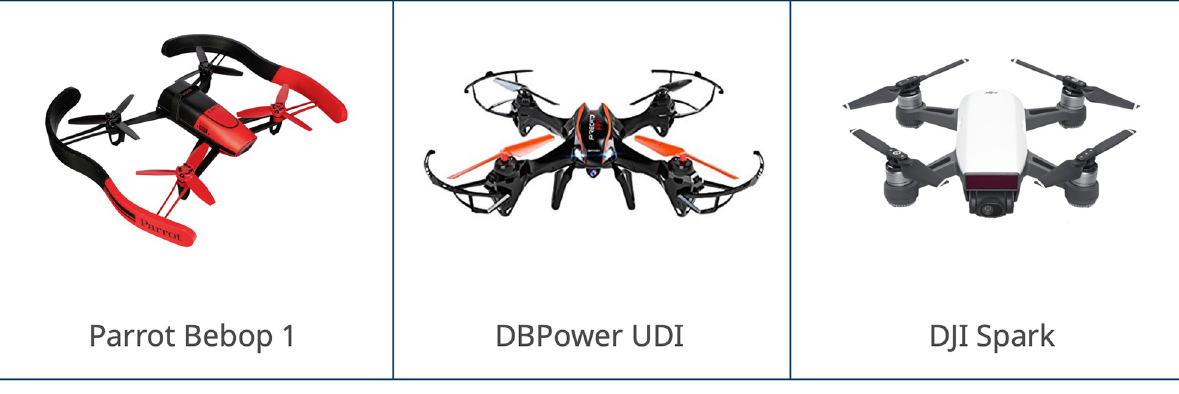
Fig 2. Types of drones used in the dataset